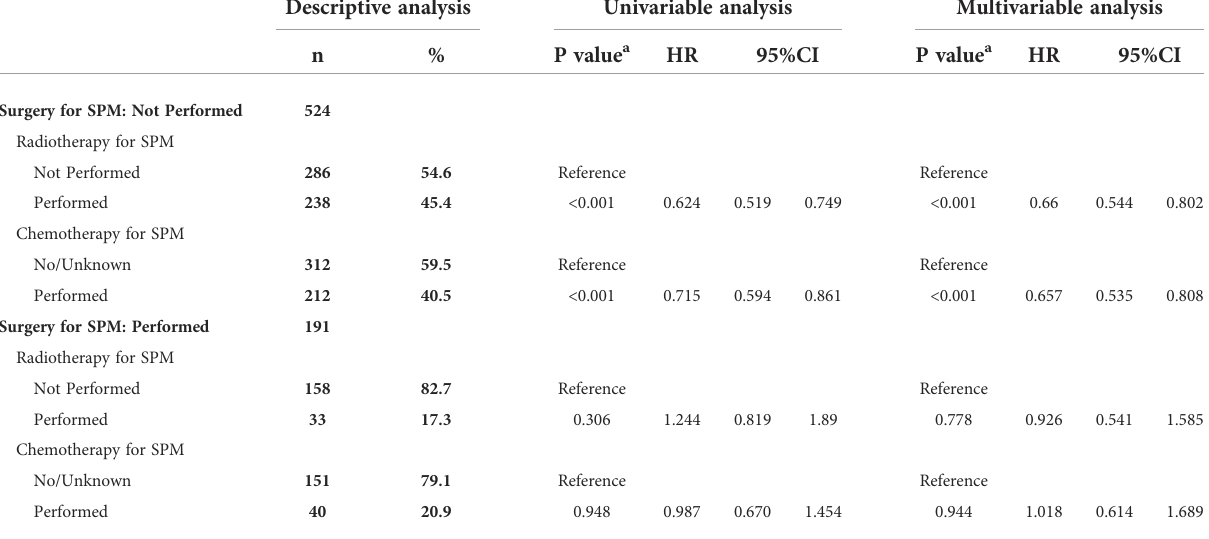
TABLE 3 Radiotherapy and chemotherapy associated with OS for SPLC-EC patients in surgery for SPM according to the Cox proportional hazards regression model. Descriptive